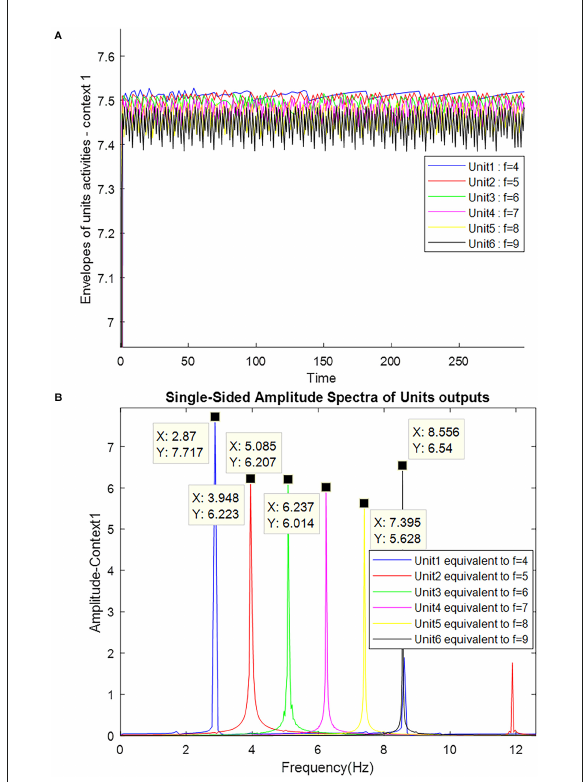
FIGURE9 ThesimulationresultsofADpatientsareshownasneuronalunits’ responses to input excitations (landmarks 1–6), in the order of encountering based on the route of context 1. (A) Amplitude envelope for neuronal units’ responses to input excitations. (B) Frequency spectrum of neuronal units’ responses to landmarks. Frequencies 4–9 in this figure are equivalent to main landmarks 1–6 in Figure 3 . The parameters for the Van-der-pol model in this simulation are λ = 15.2 B 1,...,6 = 1.5 A s = 1, P 1,...,6 = 4,5,6,7,8,9, ω s = 1,...,6